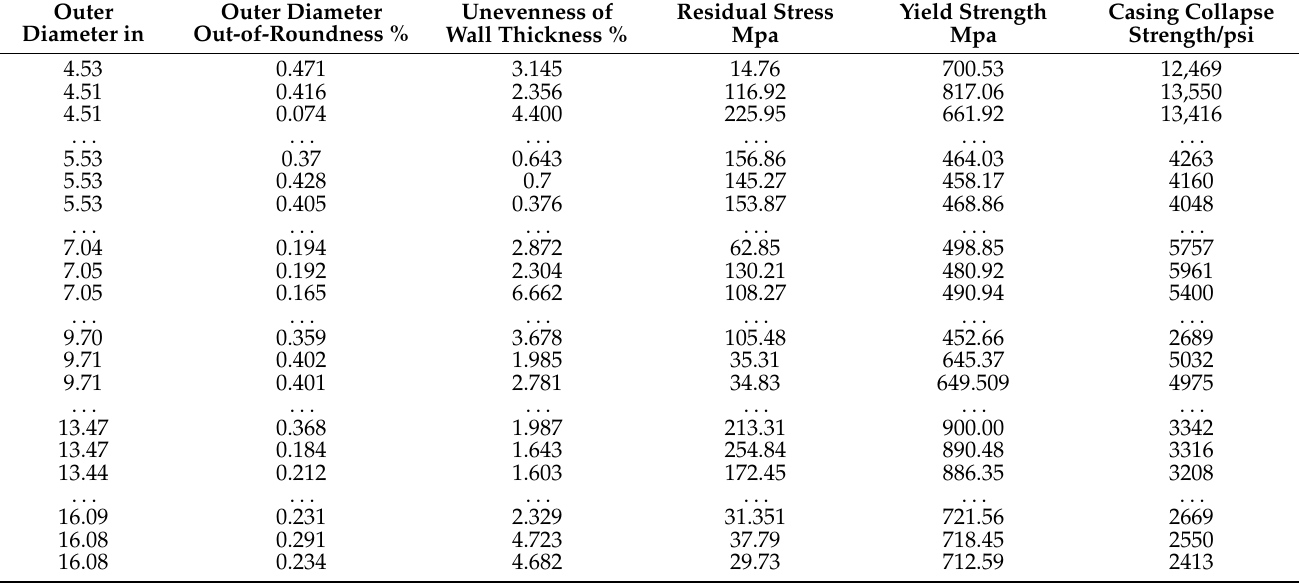
Table 3. Experimental data of casing collapse strength